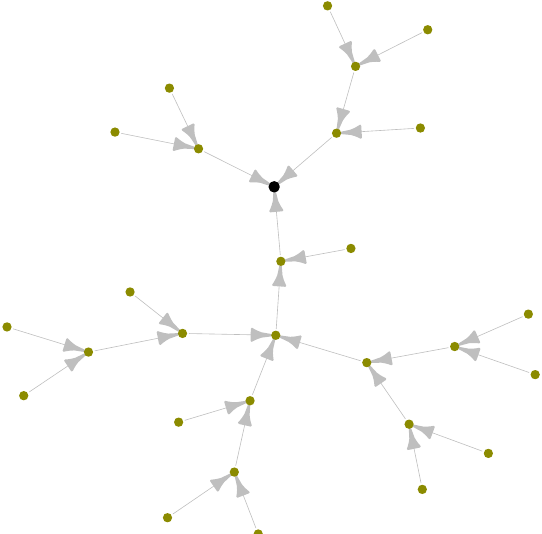
Figure 1. Oriented graph of a simple network model of the human lymphatic system suggested by Reddy et al. [3] with 29 nodes and 28 edges. The black node with out-degree deg + = 0 corresponds to jugular vein